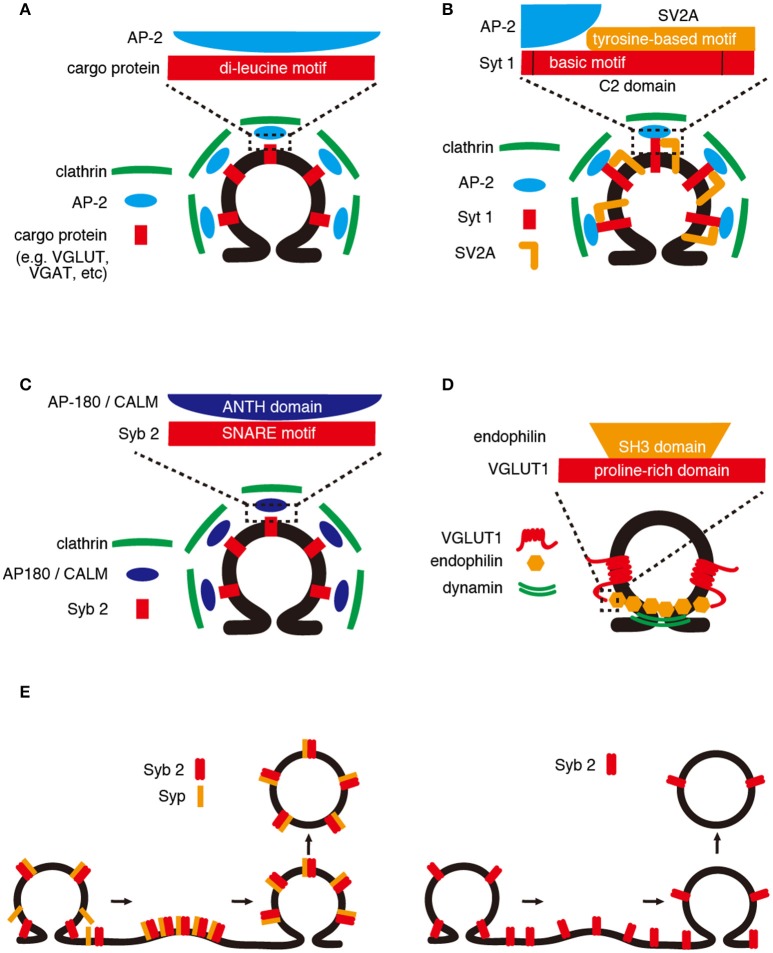
Retrieval mechanisms of SV cargos. (A) Di-leucine motif. AP-2 recognizes a di-leucine or a dileucine-like motif within the cytoplasmic region of SV cargos (e.g., VGLUT and VGAT). AP-2/cargo protein complexes are incorporated into SV surrounded by clathrin complexes. (B) C2 domain. The basic motif within the C2 domains of Syt 1 is required for binding of AP-2, and the binding is enhanced by a tyrosine-based motif of SV2A. (C) SNARE motif. The SNARE motif of Syb2 binds to the ANTH domain of AP180/CALM, which recruits clathrin complexes. (D) Proline-rich domain. The proline-rich domain of VGLUT1 interacts with a SH3 domain of endophilin, which senses membrane curvature and recruits dynamin that mediates membrane tubulation and fission. (E) Cargo–cargo interaction. (Left panel) Syp and Syb2 form a 1:2 complex on SVs, and the complex is dissociated upon SNARE complex assembly during exocytosis. After exocytosis, the Syp/Syb2 complex is reformed and incorporated into SV. (Right panel) In the absence of Syp, the efficiency of Syb2 retrieval would be decreased.